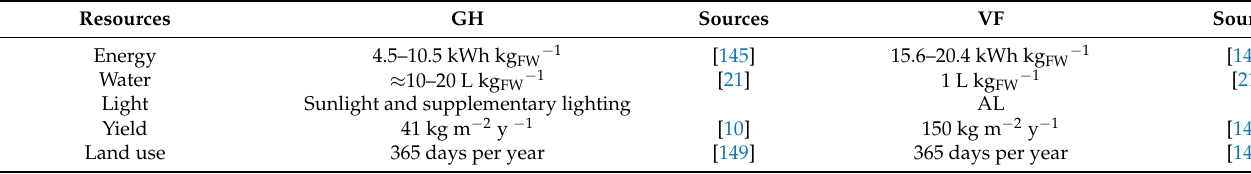
Table 3. Resource use efficiency of GHs and